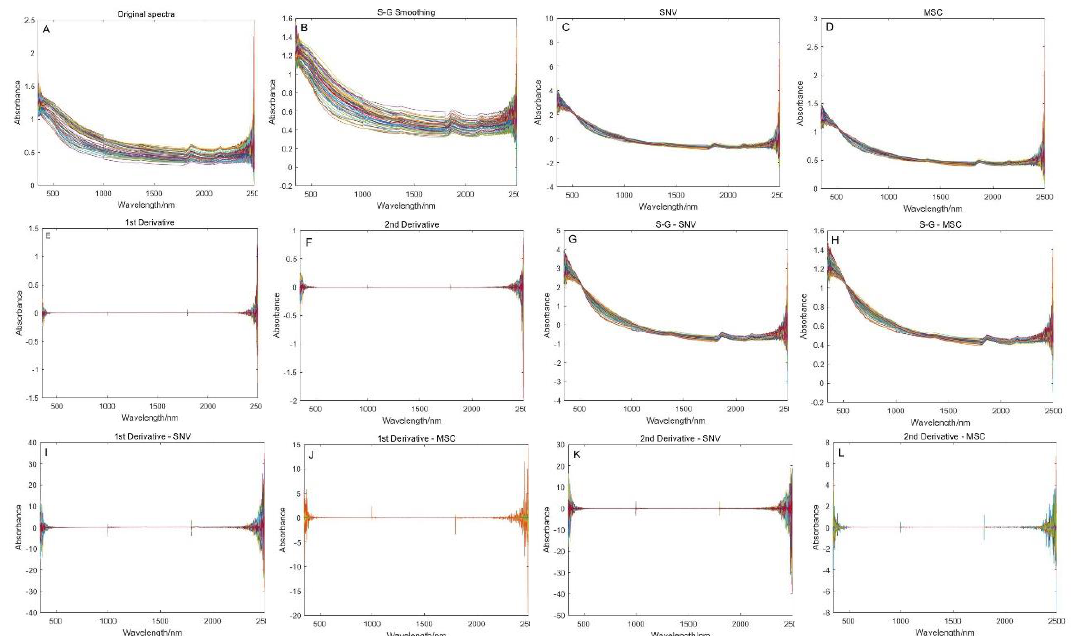
Figure 2. Pretreatment spectrum of the soil organic matter content. ( A ) Original spectra; ( B ) S-G smoothing spectra; ( C ) SNV; ( D ) MSC; ( E ) 1st derivative; ( F ) 2nd derivative; ( G ) S-G-SNV; ( H ) S-G-MSC; ( I ) 1st derivative-SNV; ( J ) 1st derivative-MSC; ( K ) 2nd derivative-SNV; ( L ) 2nd derivative-MSC.